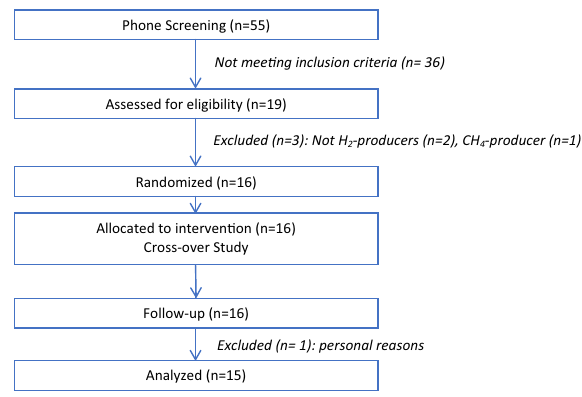
Figure 1. CONSORT flow diagram of